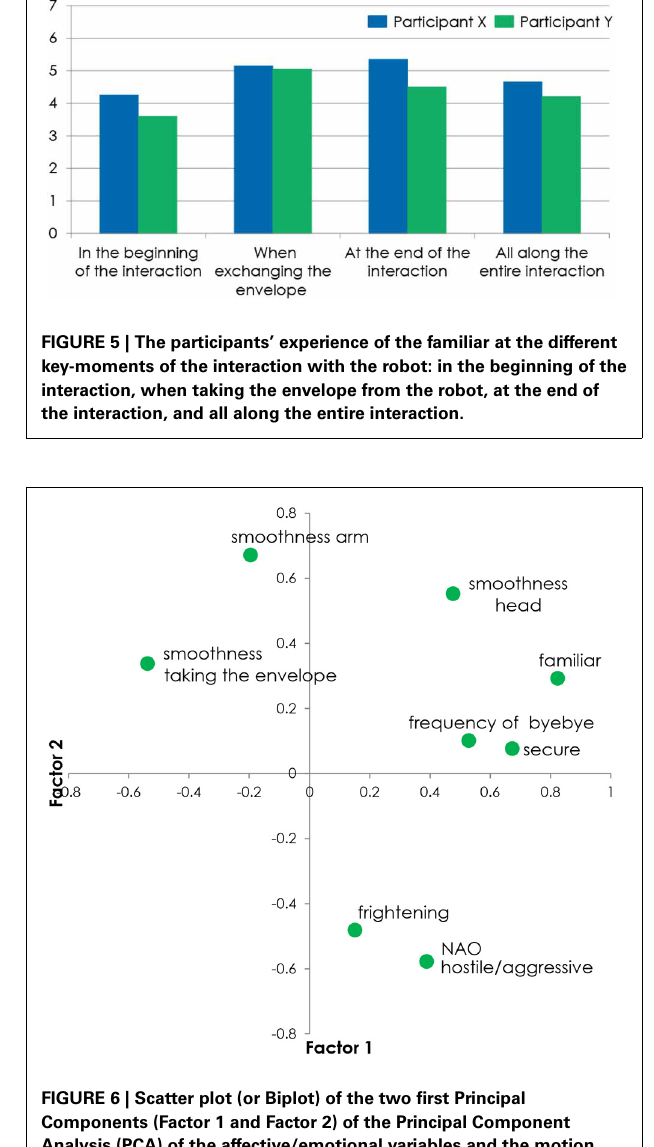
“New” (X: M = 5 . 6, SD = 2 . 0, s.e.m. = 0.4, Y: M = 5 . 1, SD